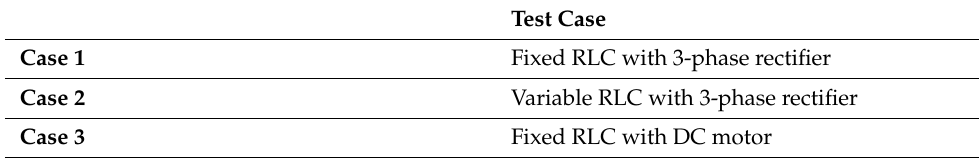
Figure 10. Case 1 GRU-based system signals. ( a ) Source current; ( b ) source voltage; ( c ) DC voltage; ( d ) neutral wire current. Table 5. Comparative analysis of the total harmonic distortion (THD). Test Case